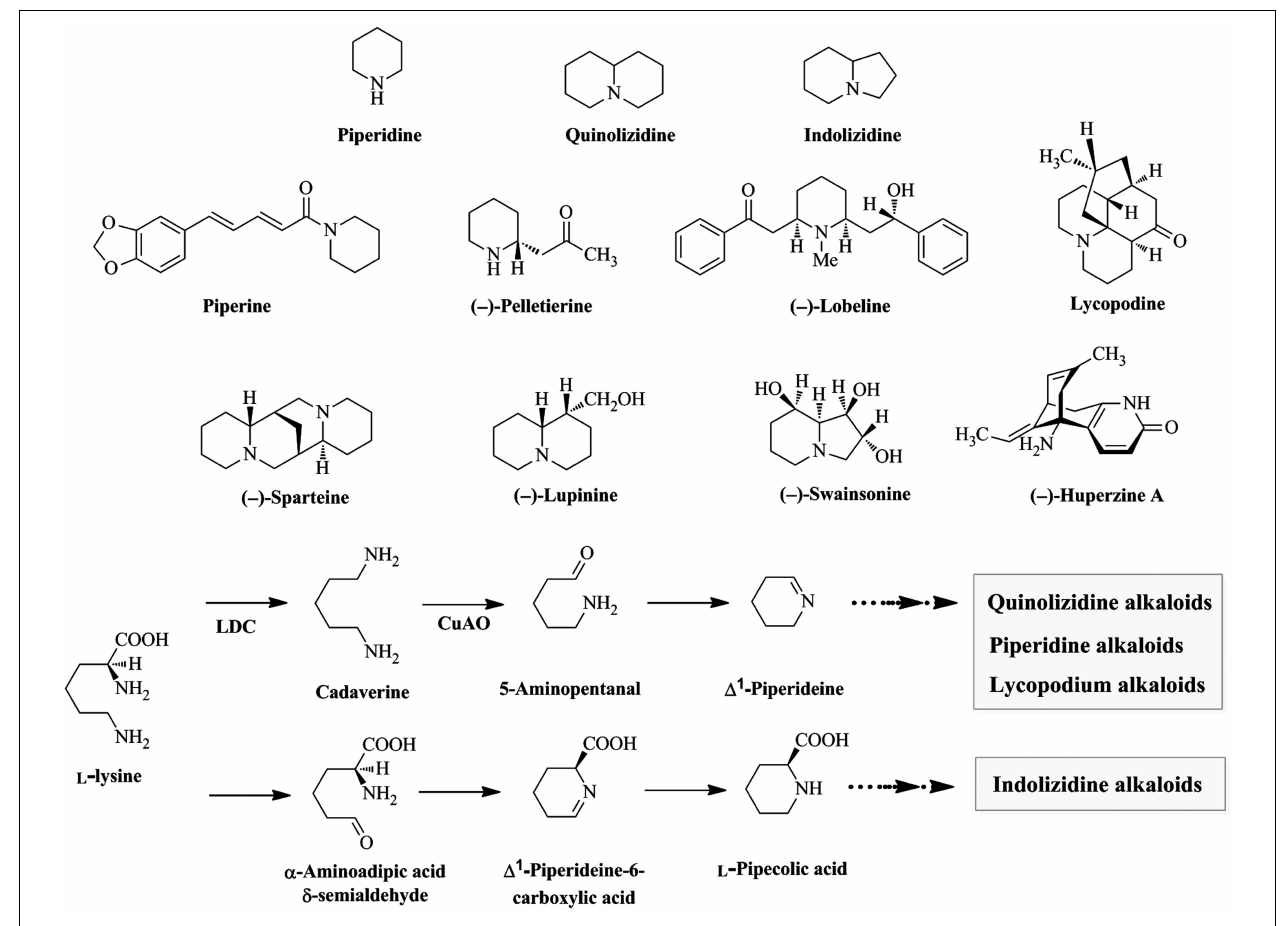
FIGURE 1 | Biosynthesis of universal intermediates, skeleton structures, and some Lys-derived alkaloids found in plants. Piperine, ( − )-pelletierine, and ( − )-lobeline are piperidine alkaloids. ( − )-Lupinine and ( − )-sparteine are